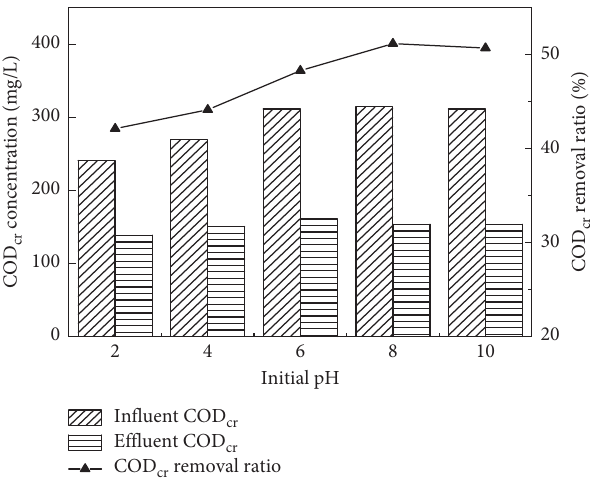
Figure 5: Effect of initial pH on COD oxidation.